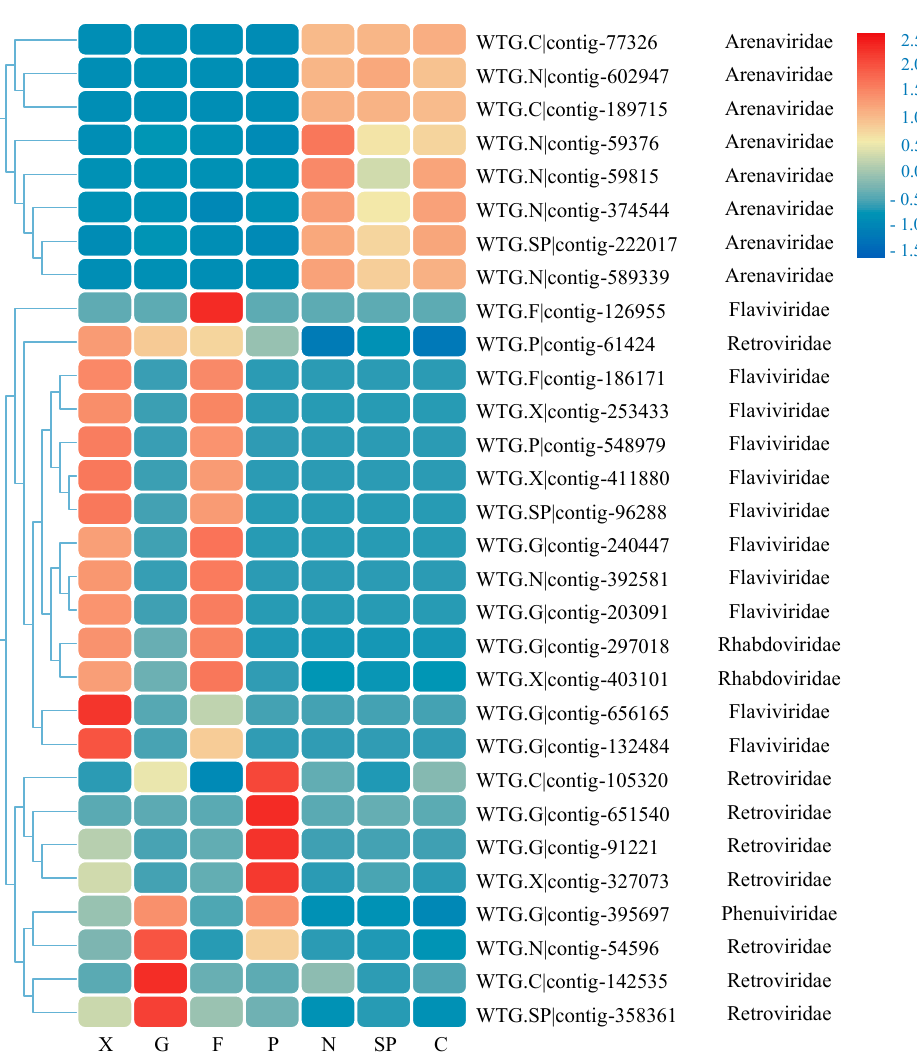
Figure 4. Heatmap of contigs with the top 30 abundance of sequence reads in each sample. The tissue types are listed below the heatmap. Information of contigs and the virus families they belong to is provided in the right text column. The boxes that are colored from blue to red represent the abundance of virus reads aligned to each contig.